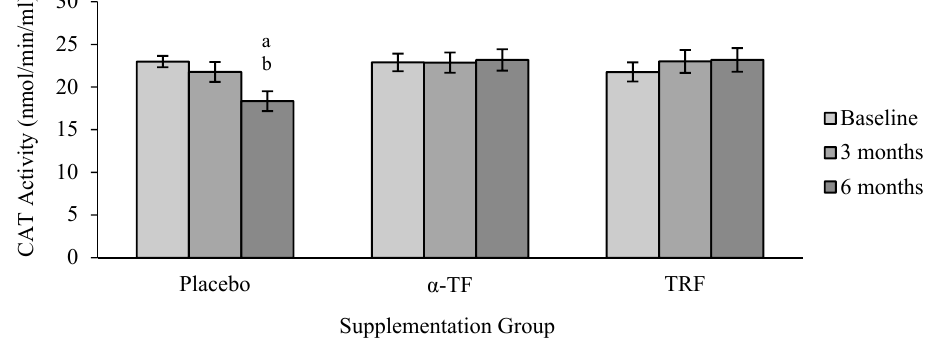
Figure 3. Effect of α -TF and TRF supplementation on catalase (CAT) activity for 6 months. a = statistically significant compared to 0-month placebo group, b = statistically significant compared to 3 months placebo group, p < 0.05.